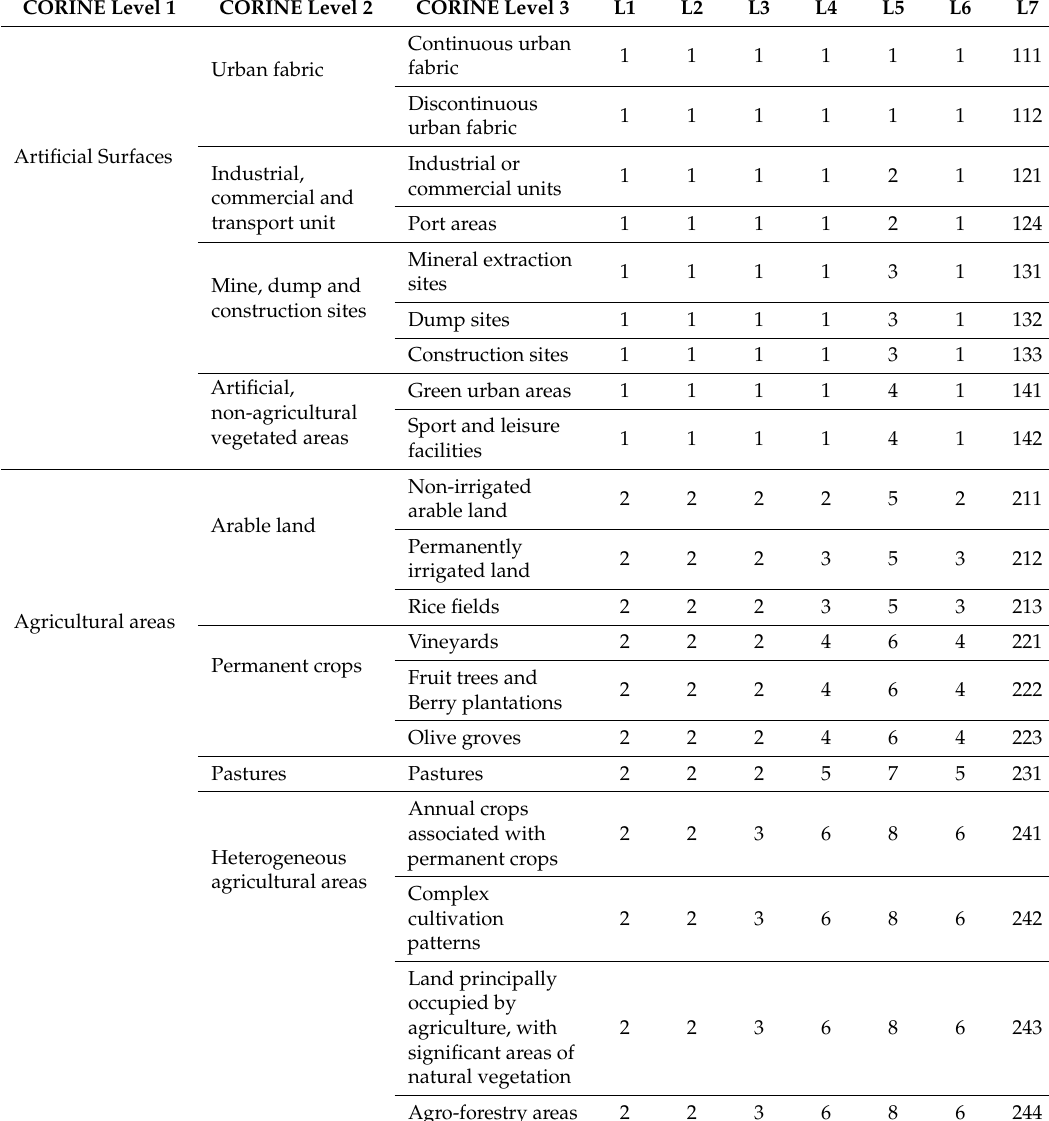
Table 1. CORINE Land Cover 2006 and the groups for every classification performed (L1, L2, L3, L4, L5, L6, and L7) in the present